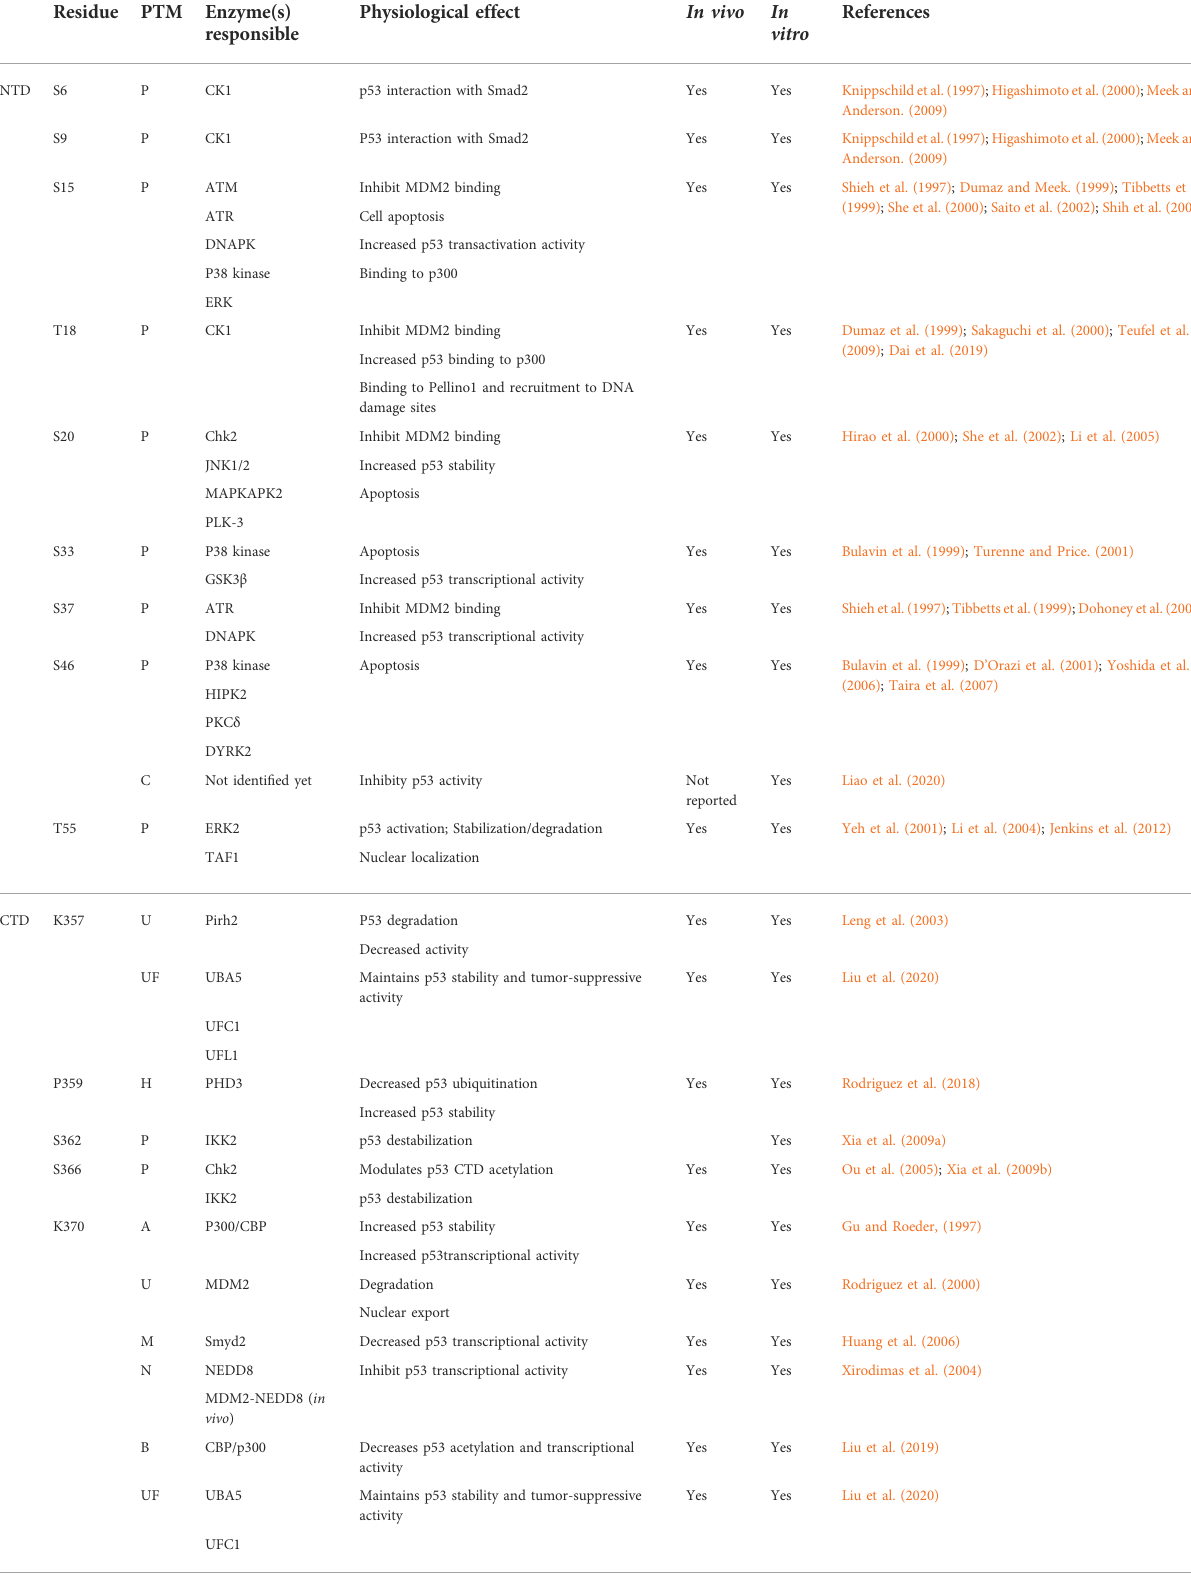
TABLE 1 The molecular antennas: NTD and CTD p53 residues with PTM. Residue PTM Enzyme(s)